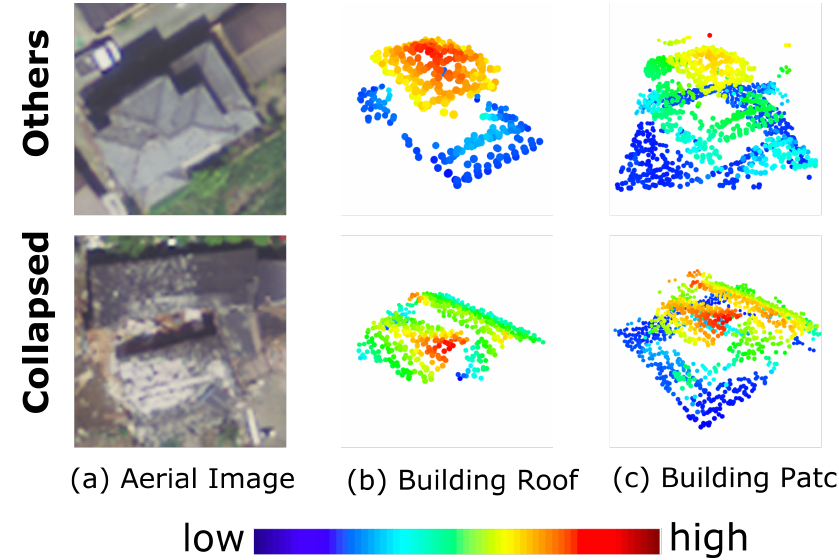
Figure 5. Examples of annotated buildings. Aerial images were provided by [12]. The point clouds are color-coded by their height values.